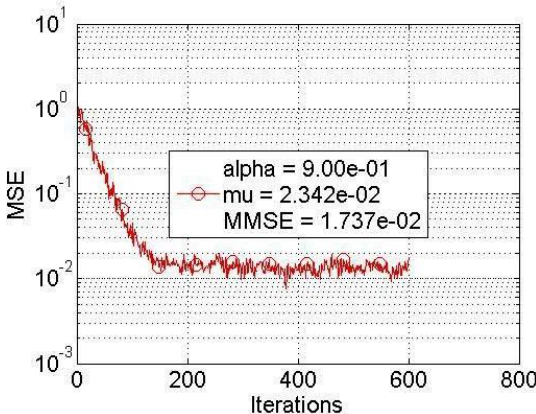
Figure 12: Representing the convergence of algorithm for the minimum value of MMSE (ACO)